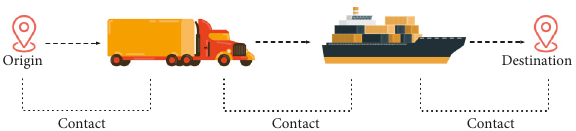
Figure 1: Sequence of multimodal